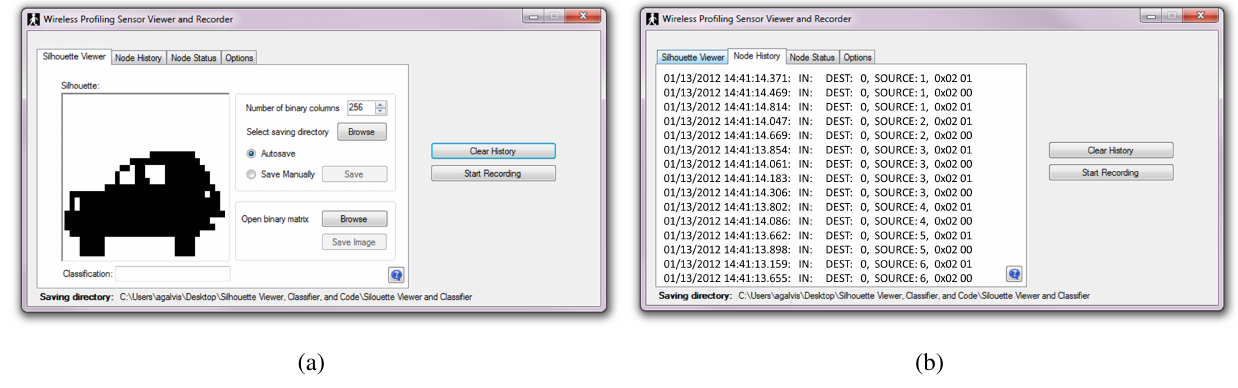
Figure 12. Second two tabs of the silhouette viewer and classifier software ( a ) Three